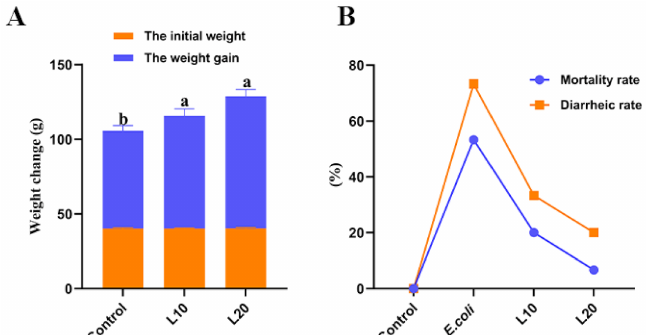
Figure 1. ( A ) Body-weight changes of chicks fed luteolin for 13 days. ( B ) The mortality rates (%) and diarrhea rates (%) of chicks in the control group, E. coli group, L10 (10 mg/kg luteolin) group, and L20 (20 mg/kg luteolin) group after E. coli injection. The data are expressed as mean ± SD. A statistical difference ( p < 0.05) is indicated using different